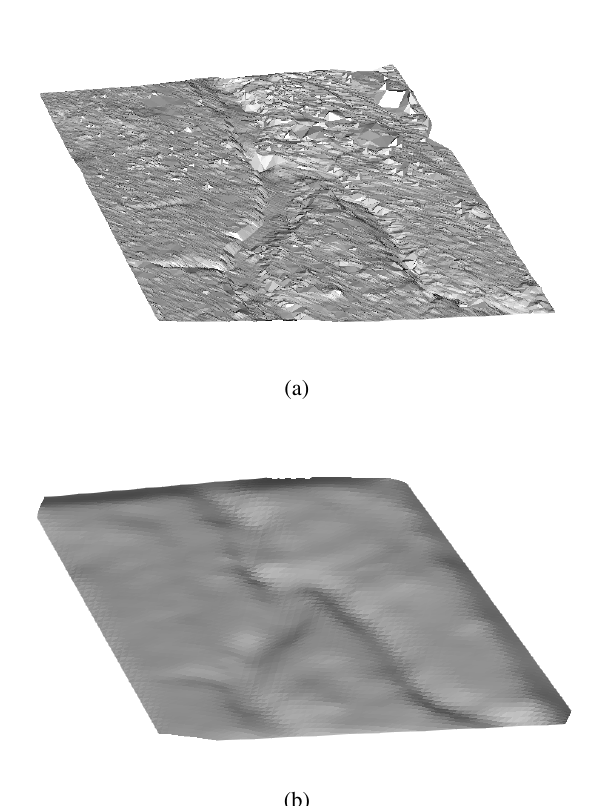
Figure 2. Comparison of a Delaunay triangulation (a, done with the software Cloud Compare 1 ) and the reconstruction of a regular 2.5D DEM